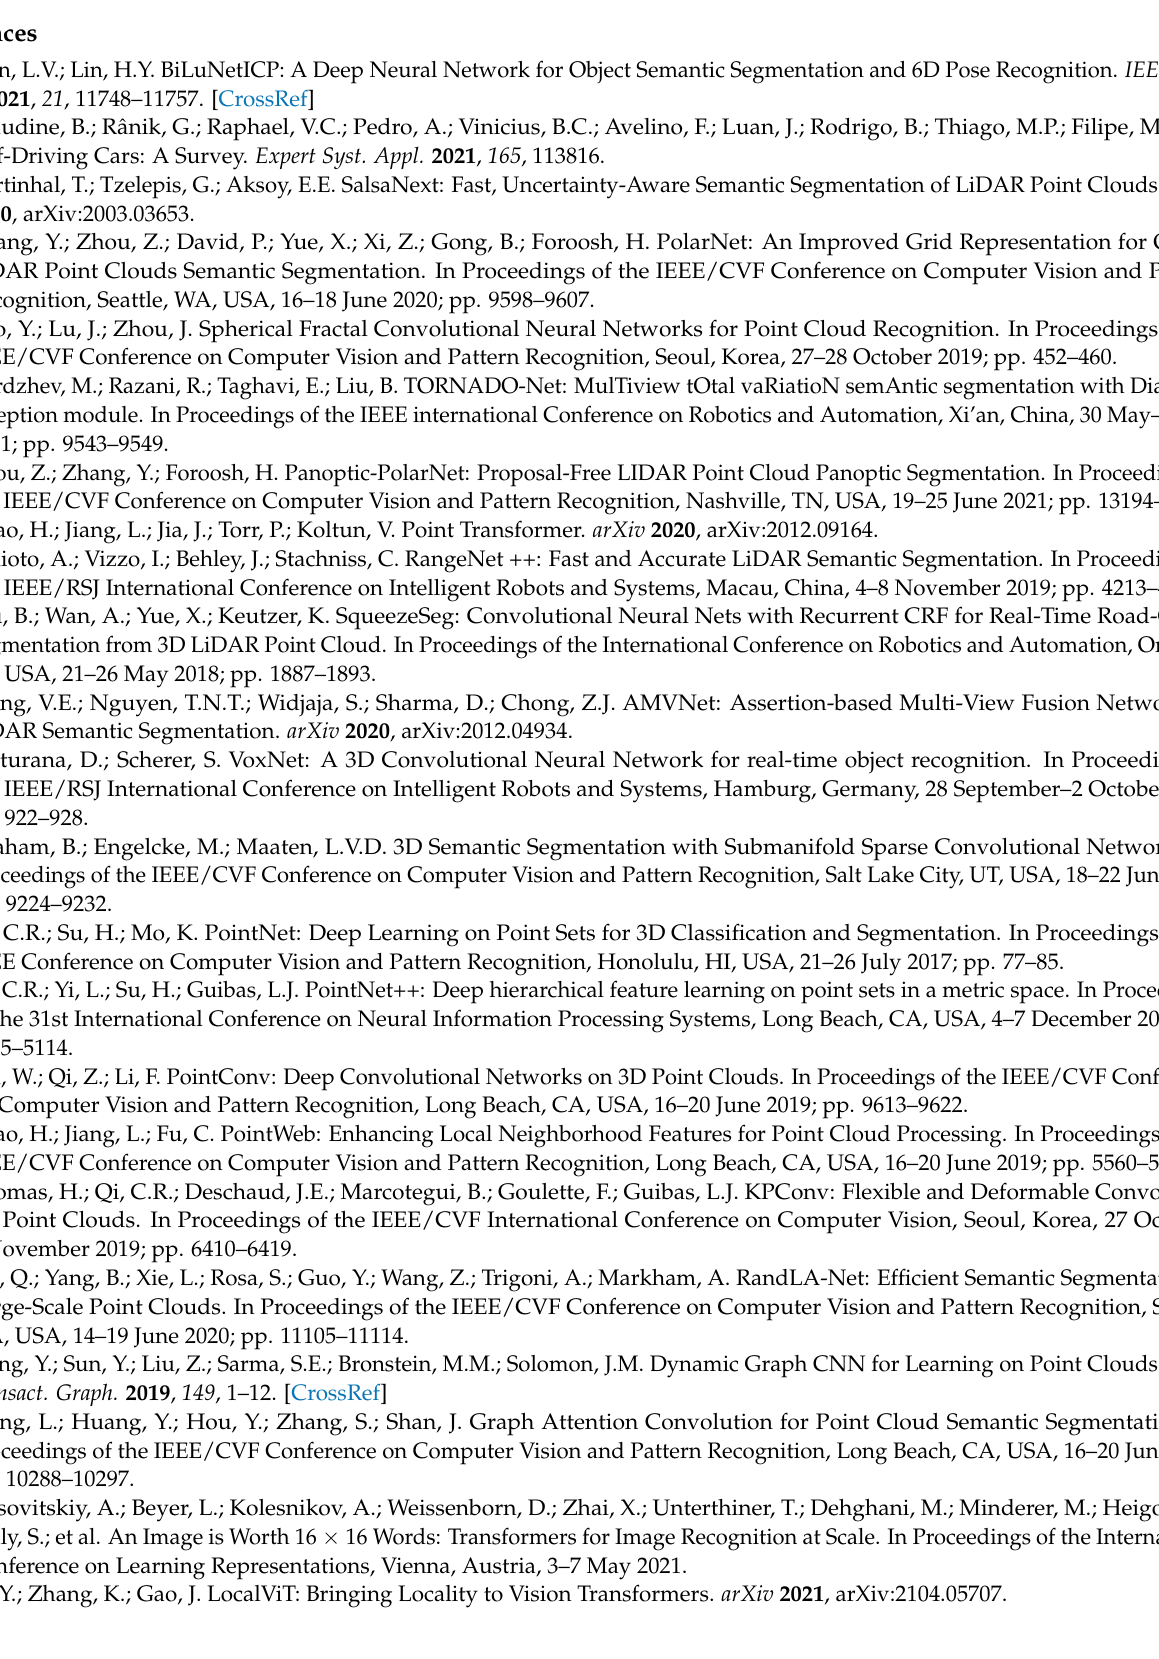
Figure A1. Visualization of the attention weight matrices. The first column is W add obtained using Formula (16). The second and the third columns are W 1 and W 2 when using the second fusion method, which can be obtained using Formulas (13) and